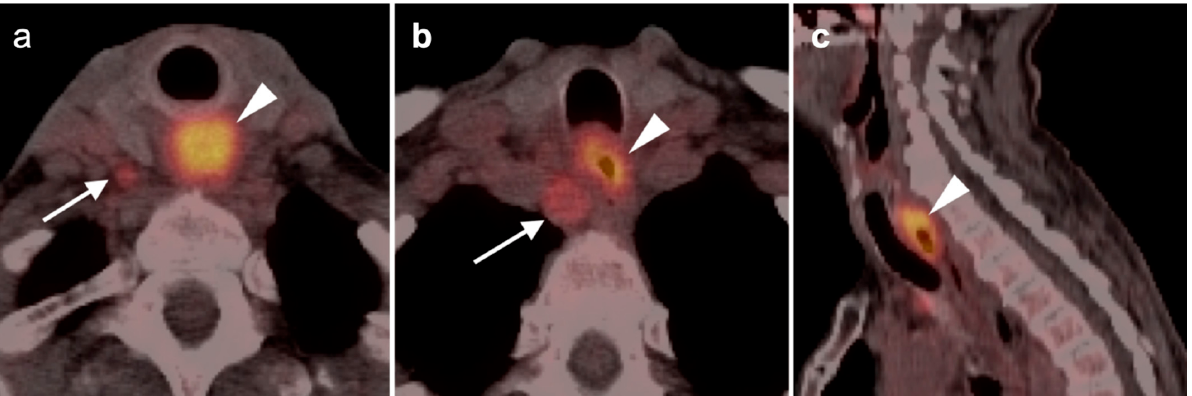
Figure 16. Cervical esophageal squamous cell carcinoma. ( a , b ) Axial and ( c ) sagittal FDG PET ‐ CT images demonstrate a hypermetabolic cervical esophageal circumferential mass (white arrowheads) with adjacent hypermetabolic lymph nodes (white arrows).